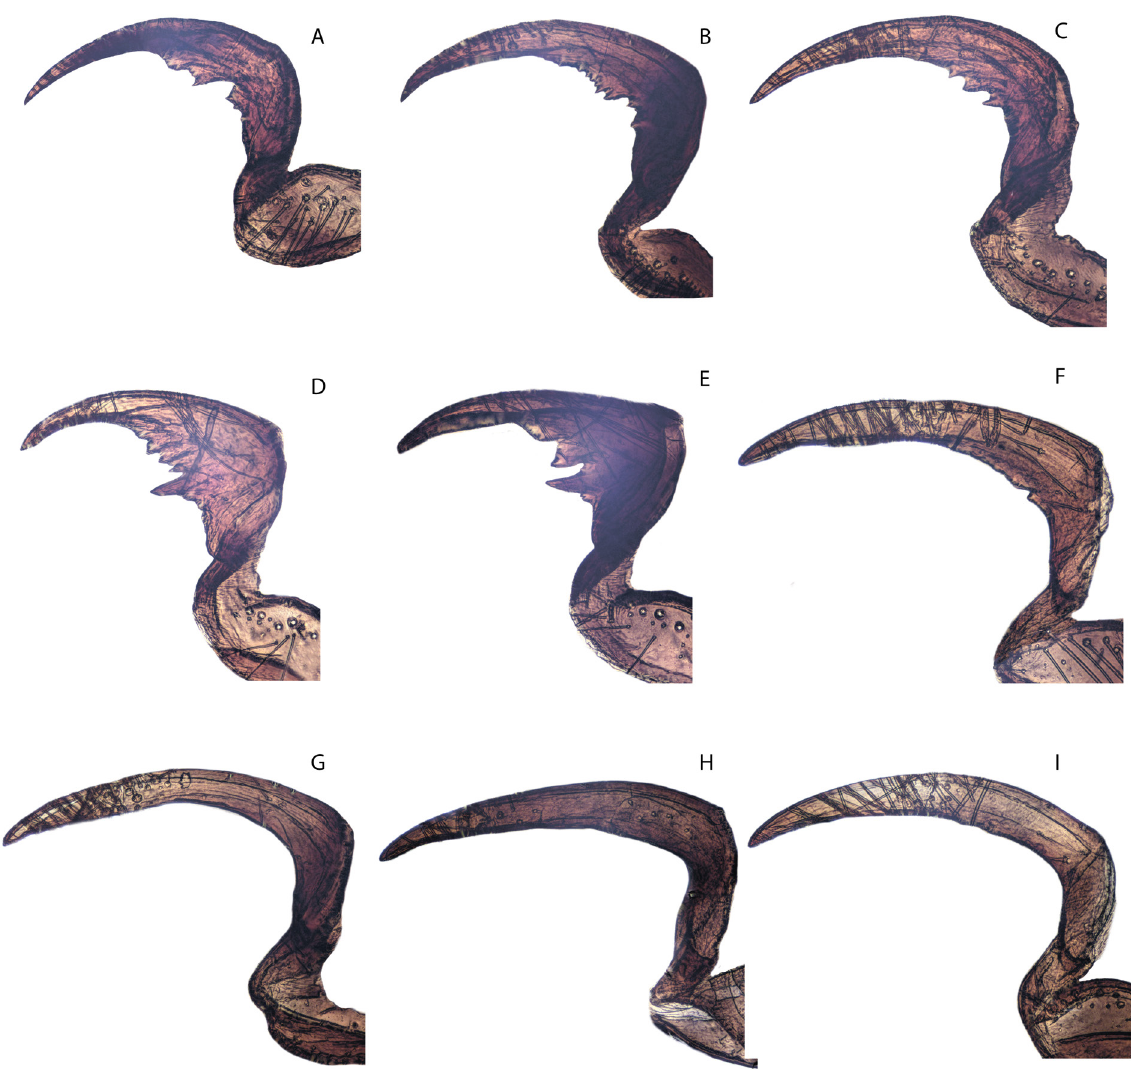
Fig. 18. Male genitalia and harpe. A–C . Melitaea shahvarica sp. nov. D–E . M. lutko Evans,